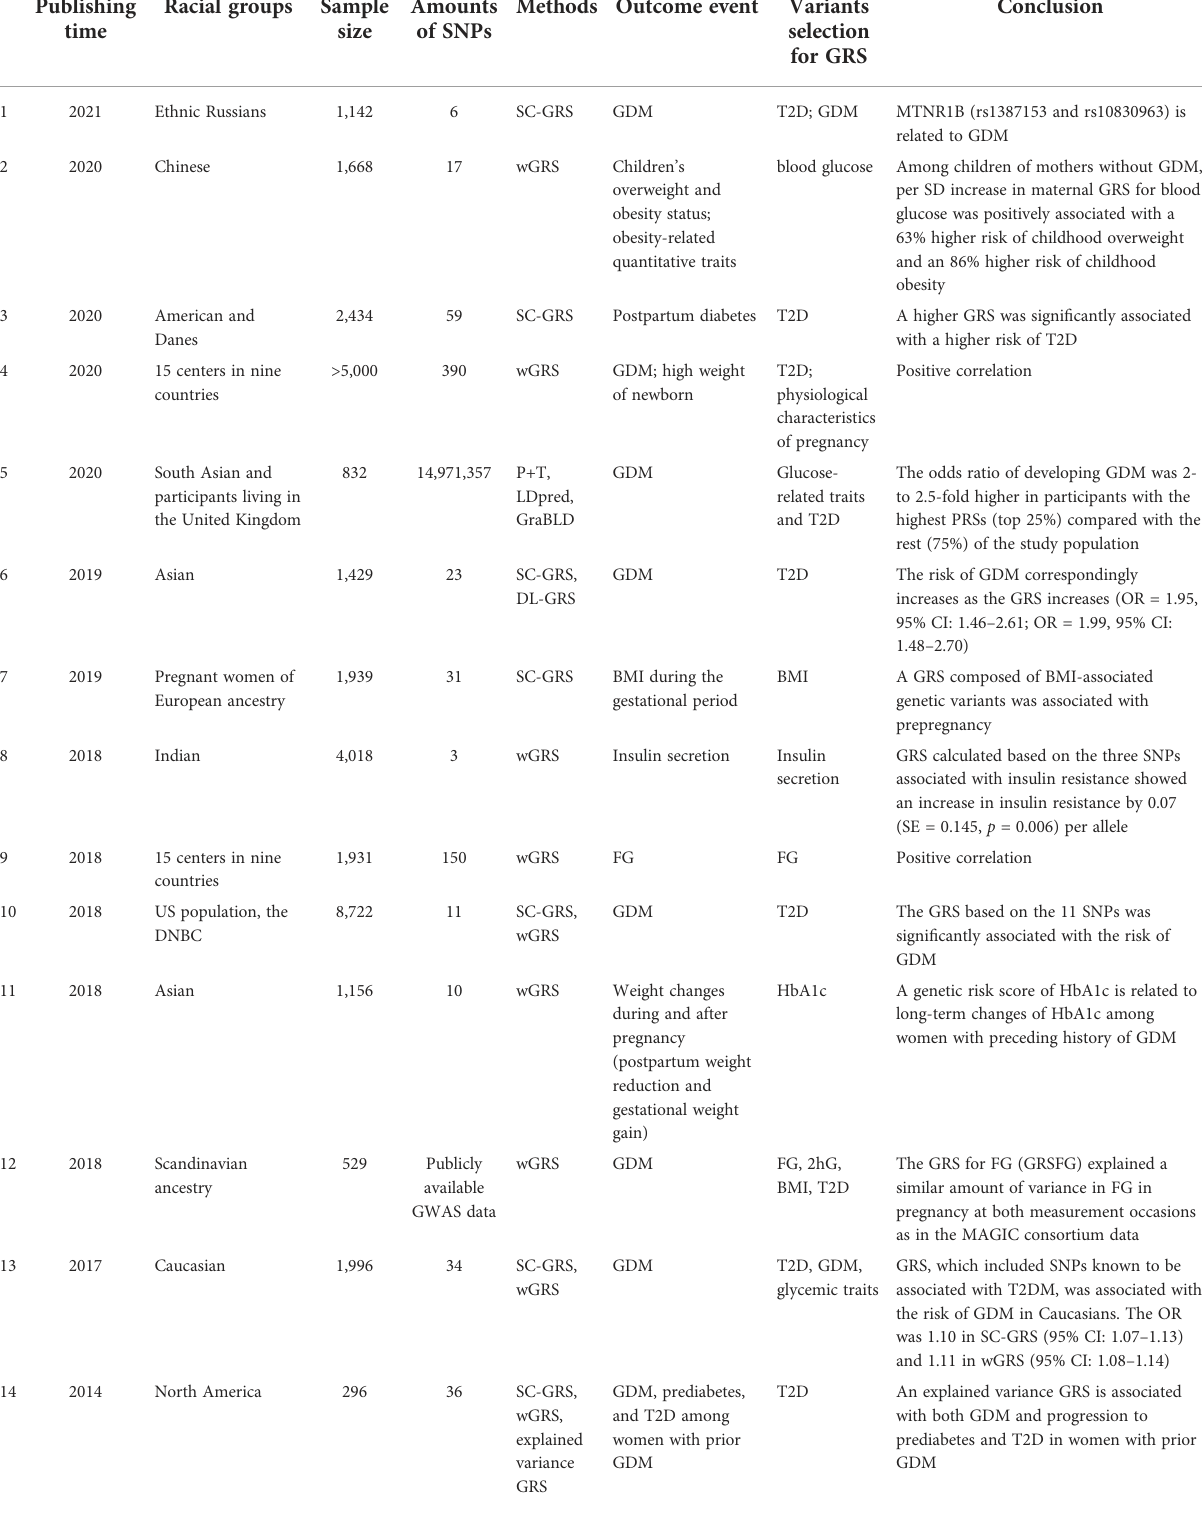
TABLE 2 Genetic risk score in the studies on